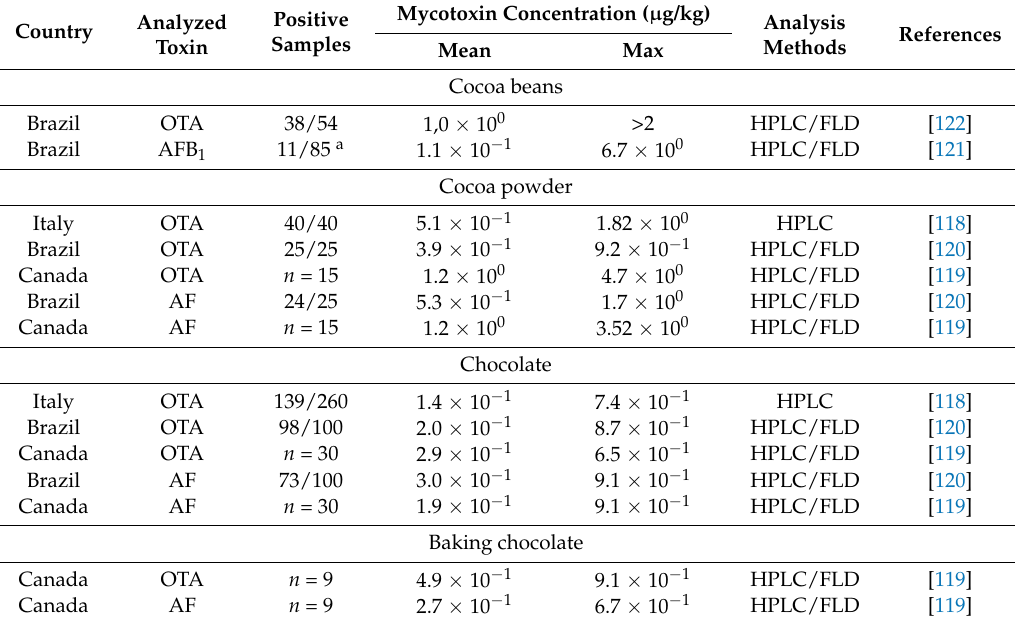
Table 4. Mycotoxin contamination found in cocoa and cocoa-derived